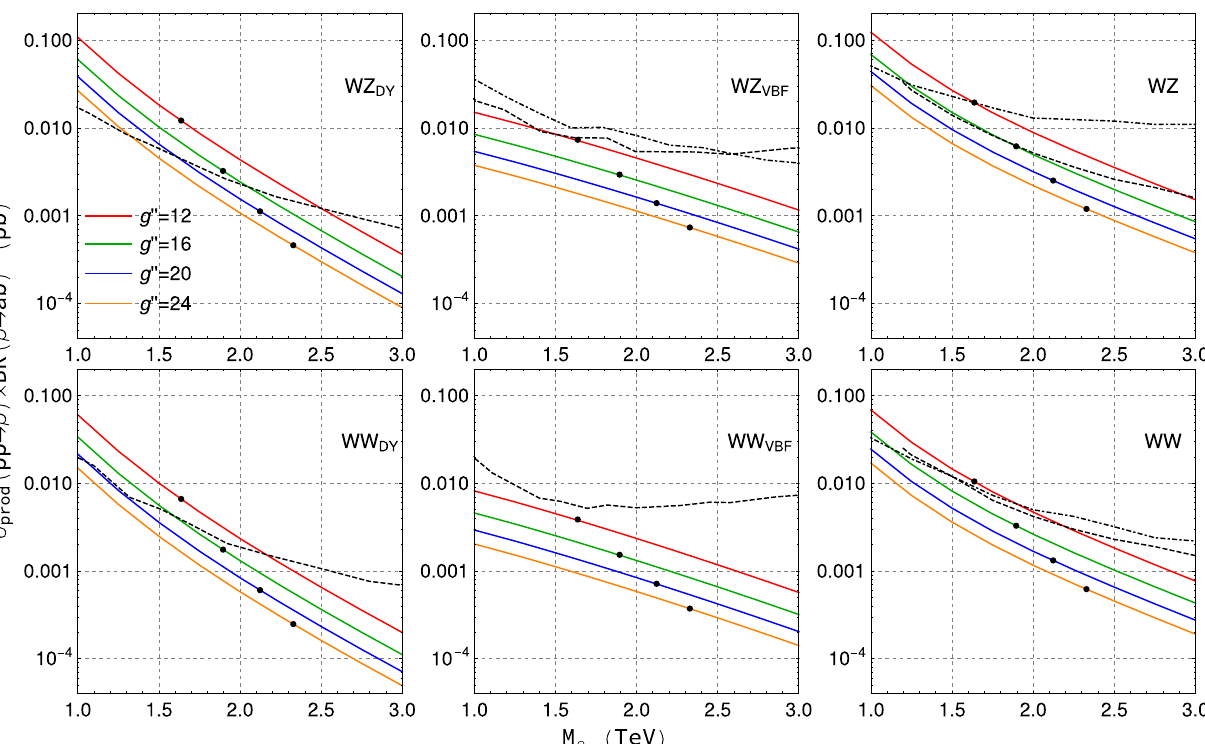
Fig. 8 The plots of σ prod × BR predicted by the tBESS model for the WW and W Z channels (solid lines) along with the relevant experi- mental upper bounds (dashed and dot-dashed lines) as functions of M ρ assuming no direct interactions of the vector tripletwith the top and bot- tom quarks. The predicted cross sections are shown for four different values of g (cid:2)(cid:2) : 12 (red), 16 (green), 20 (blue), 24 (orange). They decrease